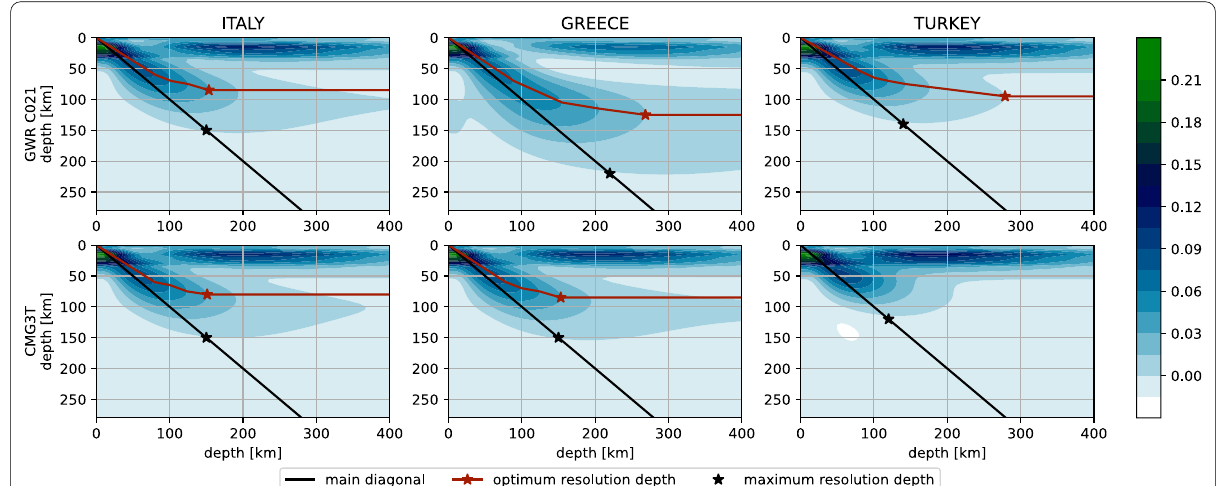
Fig. 7 Resolution matrices of the inversion scheme for the GWR C021 superconducting gravimeter and CMG3T broadband seismometer (Membach) for three regions: Italy, Greece and Western Turkey. The maximum resolution depth is marked with a black star and the optimum resolution depth with a red